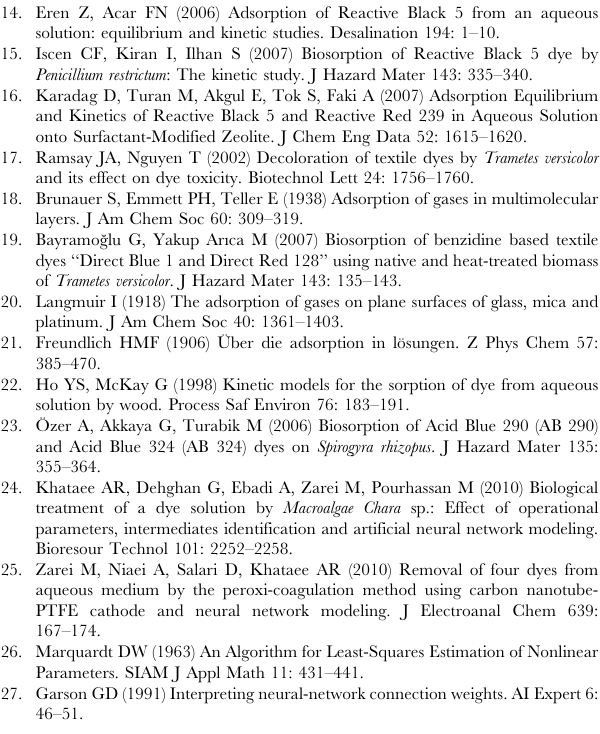
Figure S1 The effect of initial dye concentrations on biosorption capacities of biosorbents for Reactive Black 5 (30 6 C, 180 rpm). Figure S2 The effect of contact time on biosorption capacities of biosorbents for Reactive Black 5 (30 6 C, 180 rpm). Figure S3 The comparison between experimental val- ues and predicted values using an ANN model. The value of the determination coefficient (R 2 ) was 0.9855, indicating the ANN could be used to fit the experimental data and investigate the effect of input variables. Figure S4 The FTIR spectrum of Reactive Black 5.